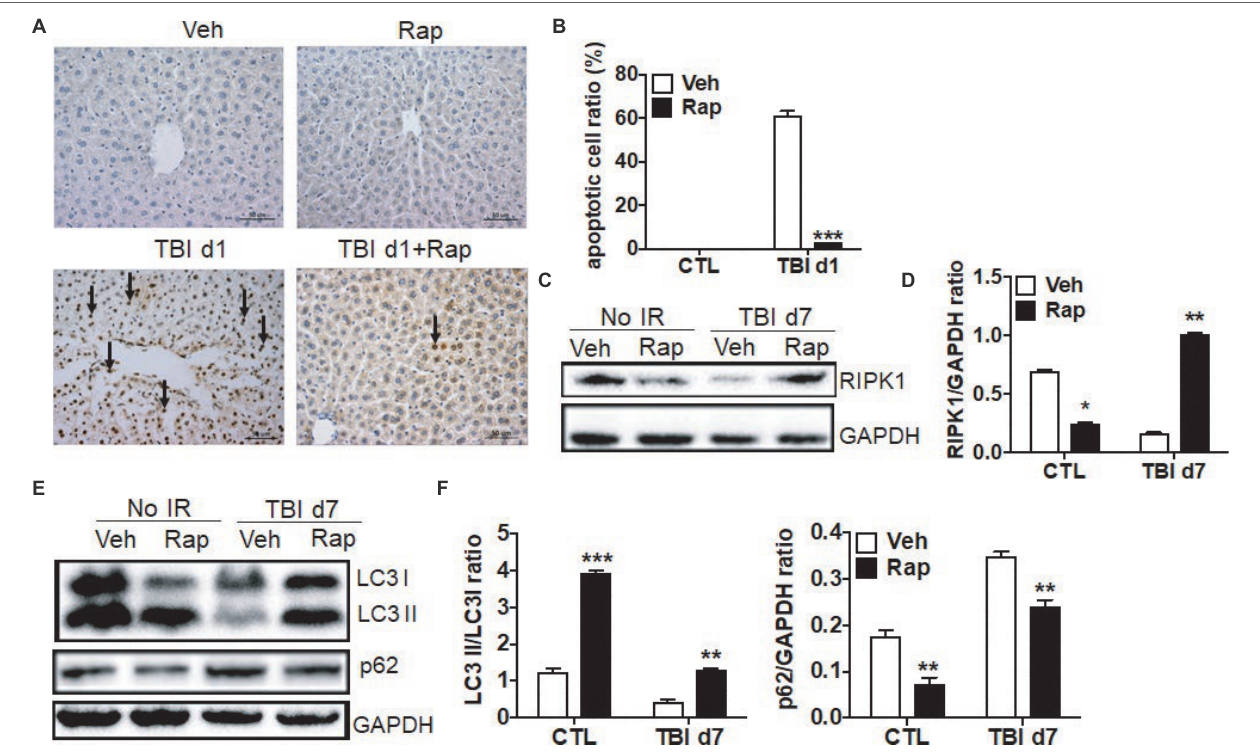
FIGURE 6 | Rapamycin treatment decreased cellular apoptosis induced by irradiation. C57BL/6J mice were treated with vehicle (Veh) or rapamycin (Rap) starting at 6 h post-exposure. Liver tissues were harvested at day 1 post-exposure. (A and B) Cellular apoptosis induced by irradiation ( n = 6). Representative pictures by TUNEL staining are shown (A) . Scale bar = 50 μ m. Arrows indicate TUNEL-positive cells. The ratios of apoptotic cells in each field were counted and are presented in B . (C and D) RIPK1 expression in liver tissues ( n = 3). Expression of RIPK1 (C) was detected by western blotting at day 7 after irradiation. GAPDH was used as a housekeeping control. Expression of RIPK1 (D) was quantitated by ImageJ software. (E and F) Expression of LC3 I, LC3 II, and p62 in liver tissues ( n = 3). Expression of LC3 I, LC3II, and p62 (E) was detected by western blotting at day 7 after irradiation. GAPDH was used as a housekeeping control. Expression of LC3 I, LC3 II, and p62 (F) was quantitated by ImageJ software. The ratios of LC3 II/LC3 I and p62/GAPDH are presented. * p < 0.05, ** p < 0.01, *** p < 0.001 vs.